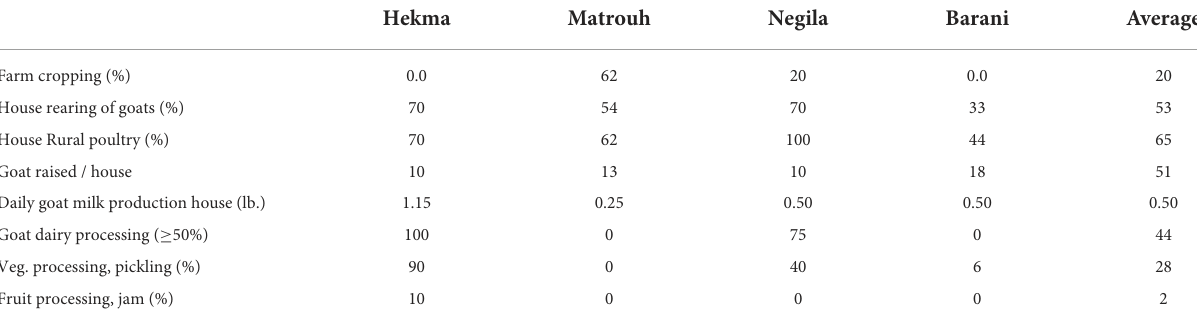
TABLE 4 Women participation in farm and house activities.